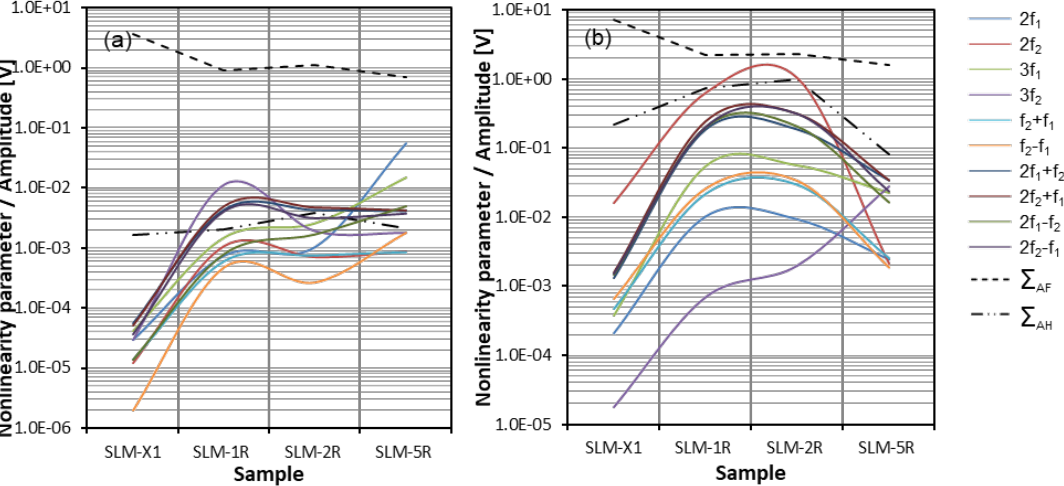
Figure 24. Nonlinearity parameter: ( a ) f 1 = 3 MHz, f 2 = 5 MHz, α = 45°; ( b ) f 1 = 4 MHz, f 2 = 5 MHz, α = 45°.